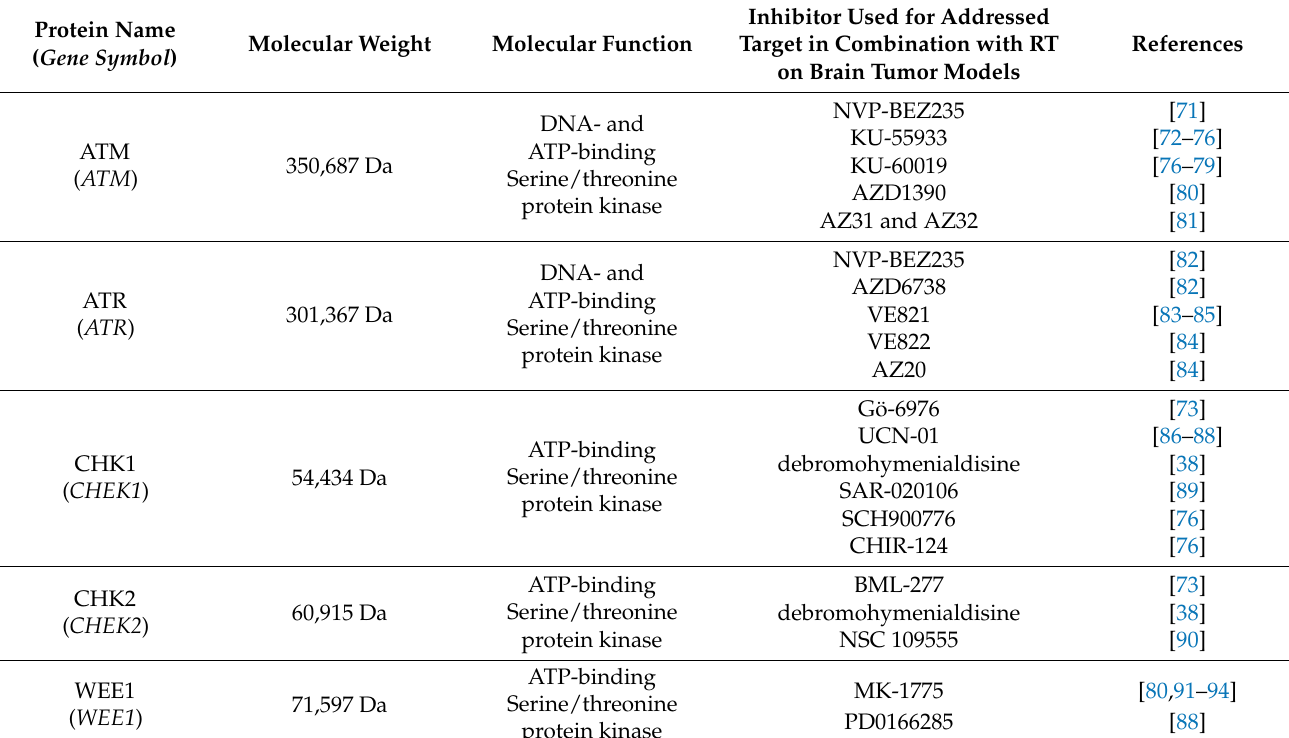
Table 1. Kinases targeted by inhibitors in combination with RT in brain